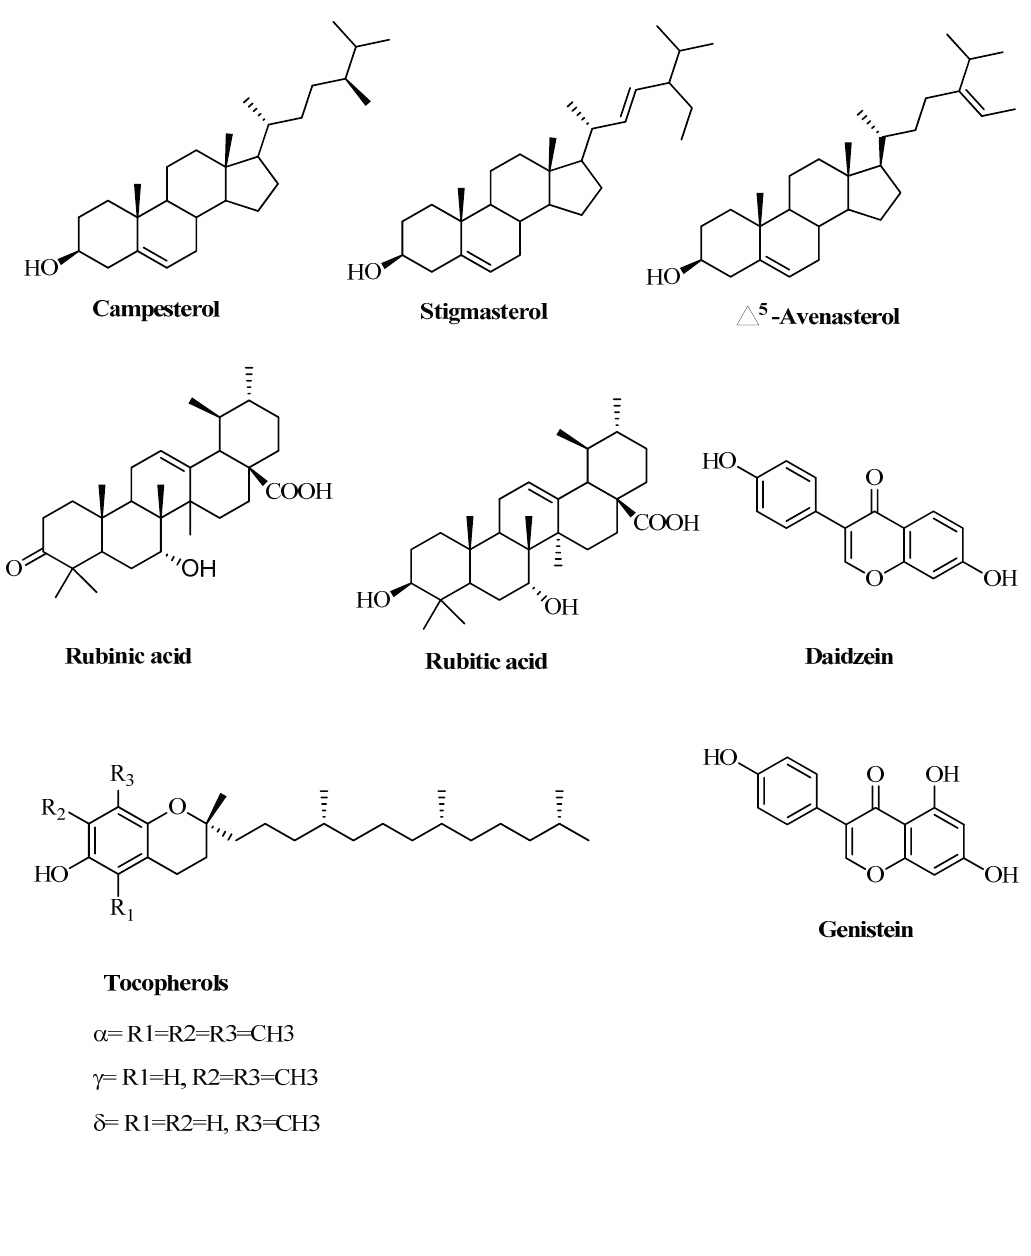
Figure 1. Phytochemicals isolated from R. fruticosus